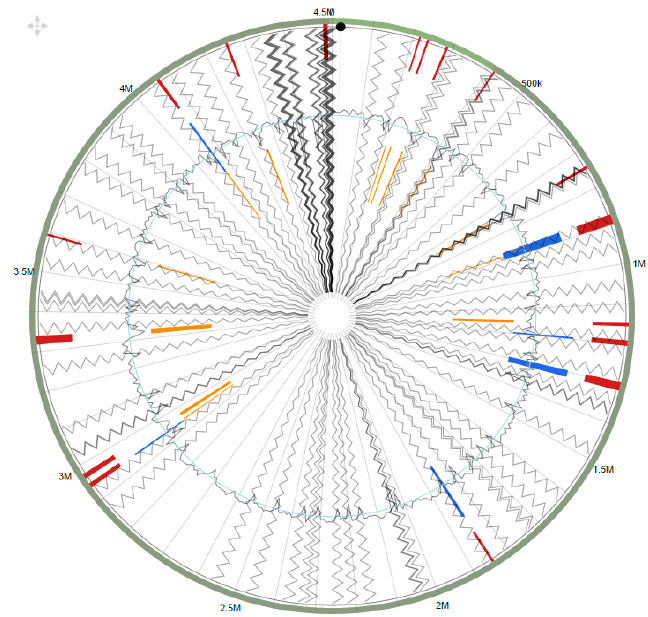
Figure 6. Shown are the putative genomic islands (GEIs) of Arthrobacter sp. strain SRS-W-1-2016. The outer green circle represents the scale line in Mbps and GEIs obtained from each of the following methods are shown in color: SIGI-HMM (orange), IslandPath-DIMOB (blue), and integrated detection (red), respectively.